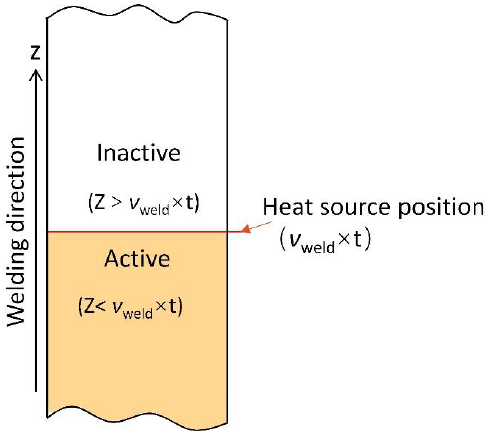
Figure 4. Schematic diagram of the activation process of the weld metal.